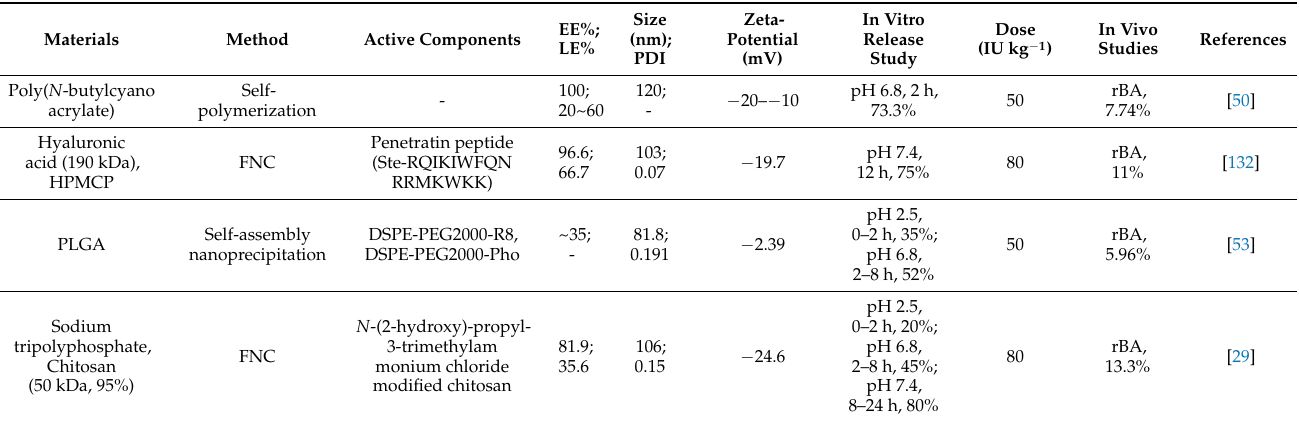
Table 6. Examples of organic nanospheres/nanocapsules as nanostructure for oral insulin delivery nanosystems.